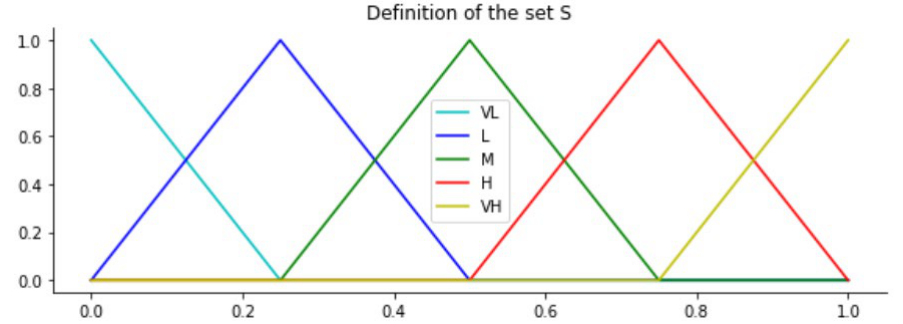
Figure 1. Definition of the set S .